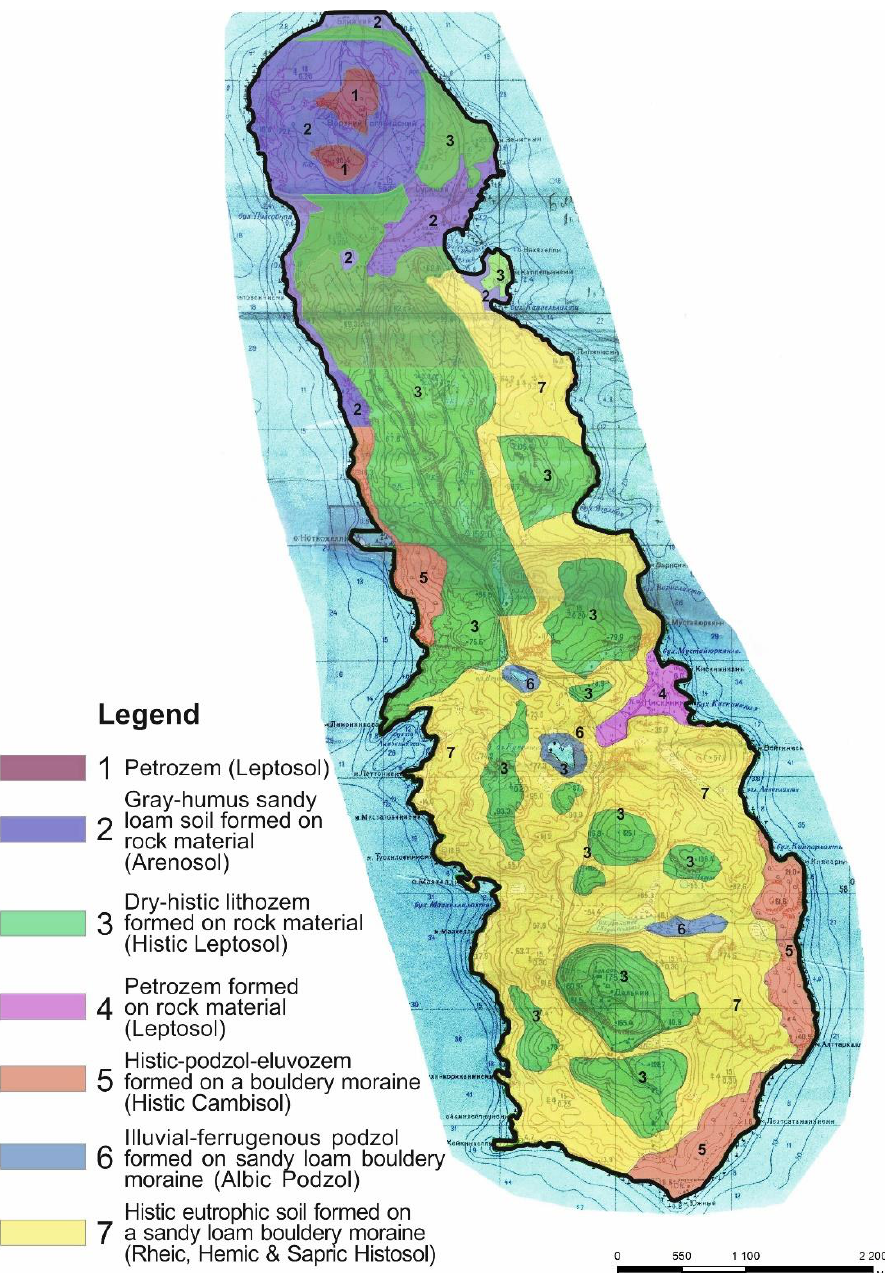
Figure 2. Soil cover map of Gogland (the author is Abakumov E.V., St. Petersburg State University). Soil names are given, according to [36]; soil names in the brackets, according to [37]. Shallow soils—Lithosol and Petrozem [36] (Leptosols—WRB) (Figure 3)—are char- acteristic of the tops of selga-type landscapes (Leptosols (Humic)), rocky outcrops, large fragments of colluvium, and rubble eluvium of granite rocks. Soils profiles are shallow (from several centimeters to several tens of centimeters). They do not have a middle fine earth horizon (B horizon). Gray-humus soils (Arenosols—WRB), with a more developed profile (Figure 4), and dry-histic lithozem (Histic Leptosols—WRB), with weakly decom- posed organic matter accumulations (Figure 5), can be found on the slopes of selga-type